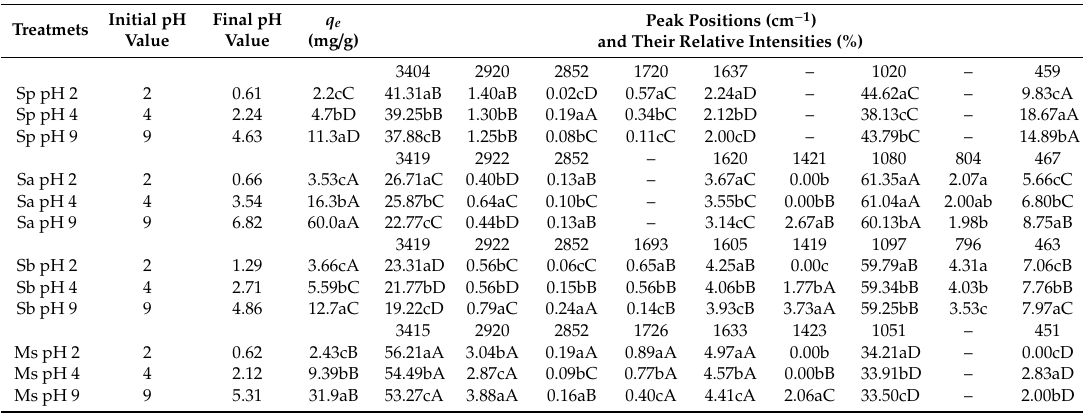
Table 2. Adsorption Capacity of Cd(II) on the Four Adsorbents from Rice Straw under Di ff erent Initial Cd(II) Concentrations and the Relative Intensities of the Absorption